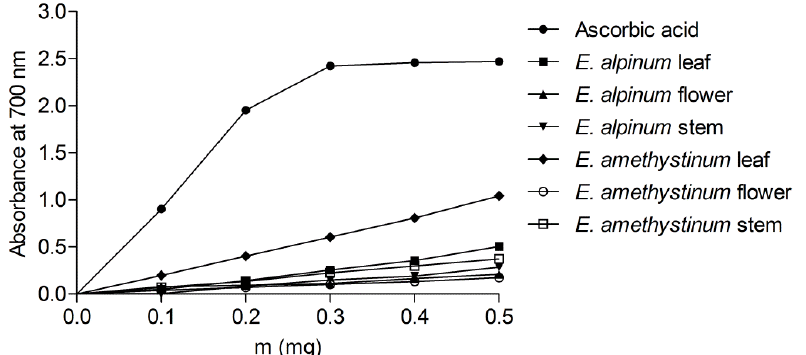
Figure 2. Reductive capacities of the Eryngium spp. extracts. Each value shown represents the mean of three independent measurements with SD error bar (SD are not visible due to their small size relative to the mean).